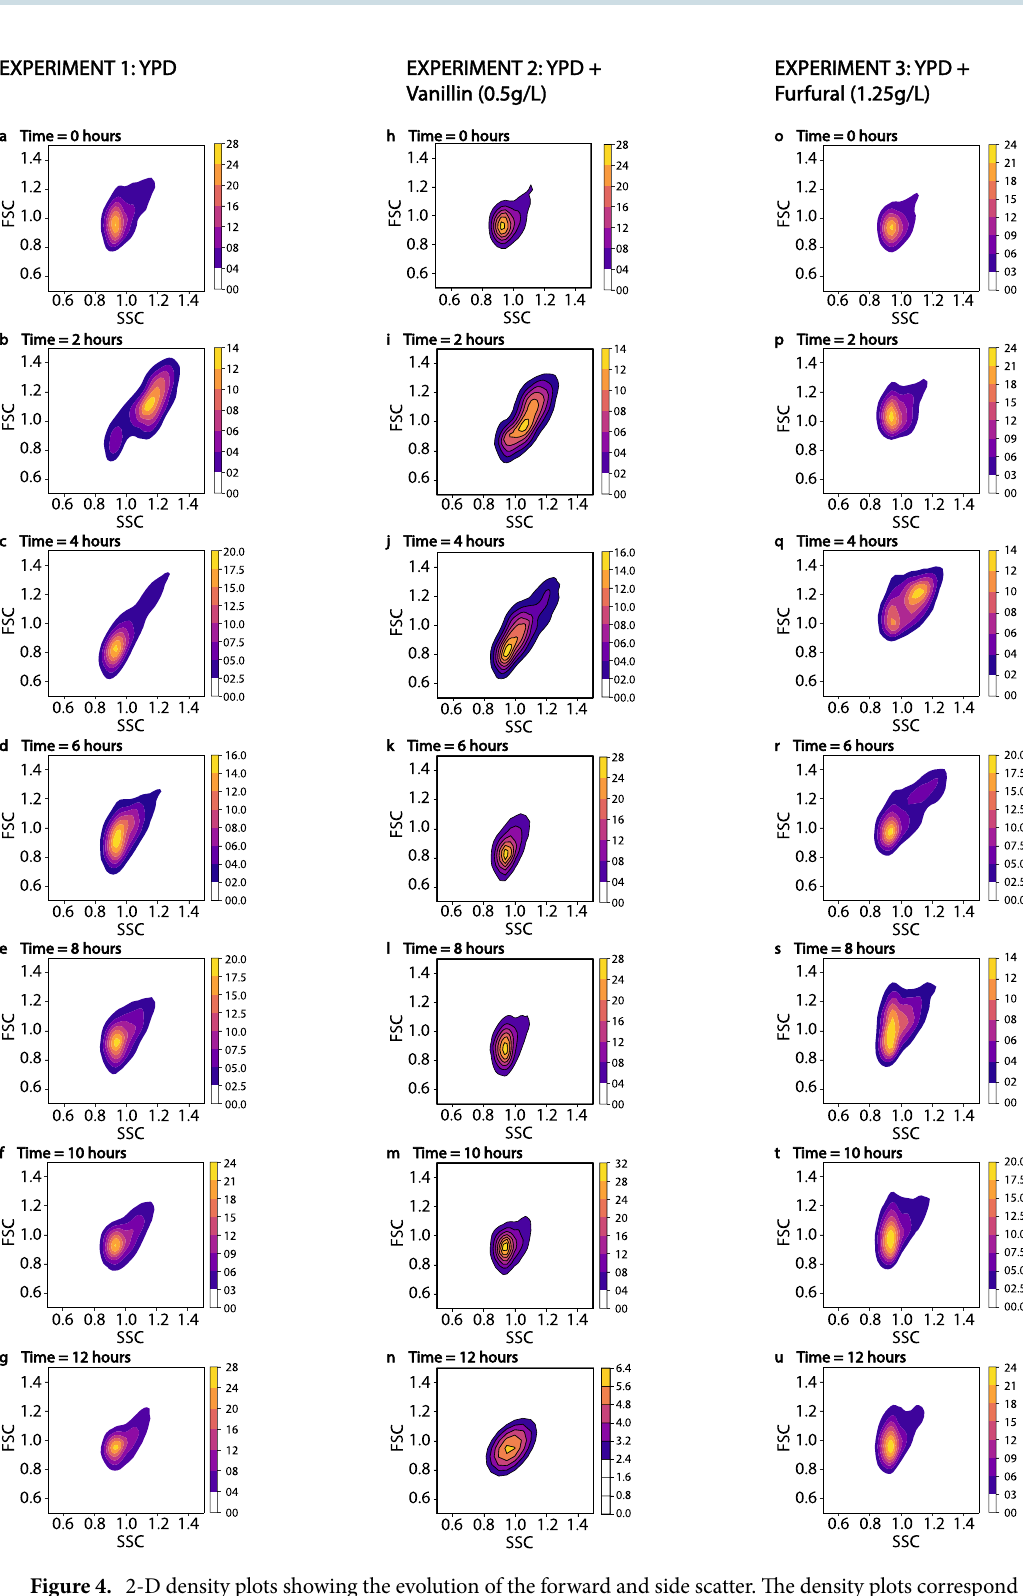
Figure 4. 2-D density plots showing the evolution of the forward and side scatter. The density plots correspond to experiment 1 ( a – g ), experiment 2 ( h – n ) and experiment 3 ( o – q ). Notice that the FSC and SSC are scaled by the mean FSC and SSC of experiment 1 at time 0 h. Hence, all measured changes in the population of cells are given in relation to that state. The colour gradient shows the density of the distribution in the populations, with yellow corresponding to the highest density, and blue corresponding to the lowest one. This figure was produced using Python 70